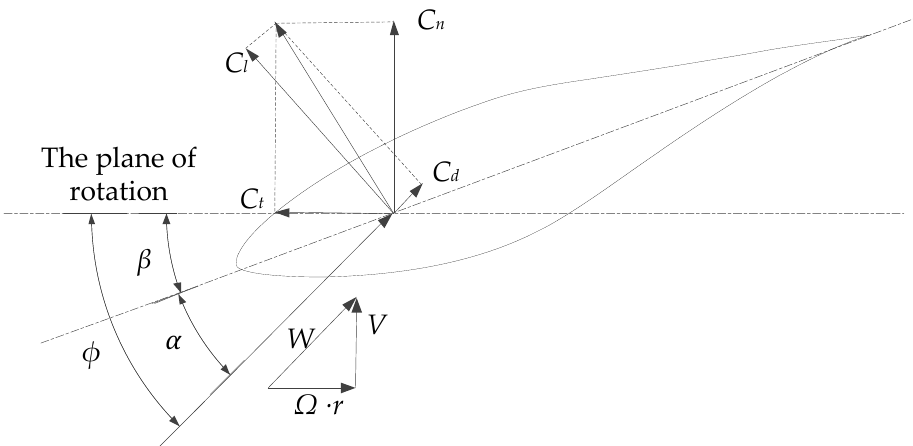
Figure 3. Schematic representation of the relationship between the velocity and force on the blade element. blade